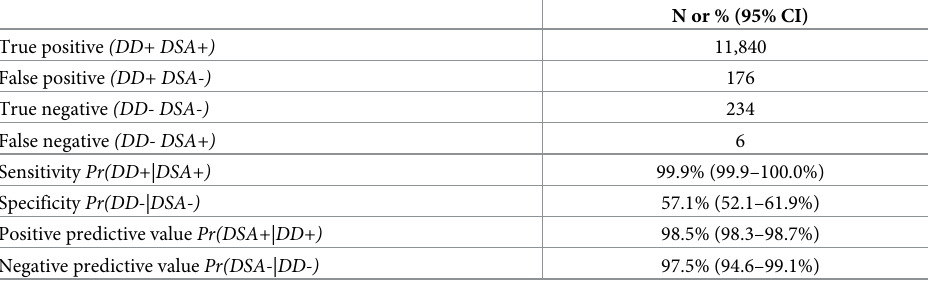
Table 3. Performance of dose diary adherence assessment compared to dye stain